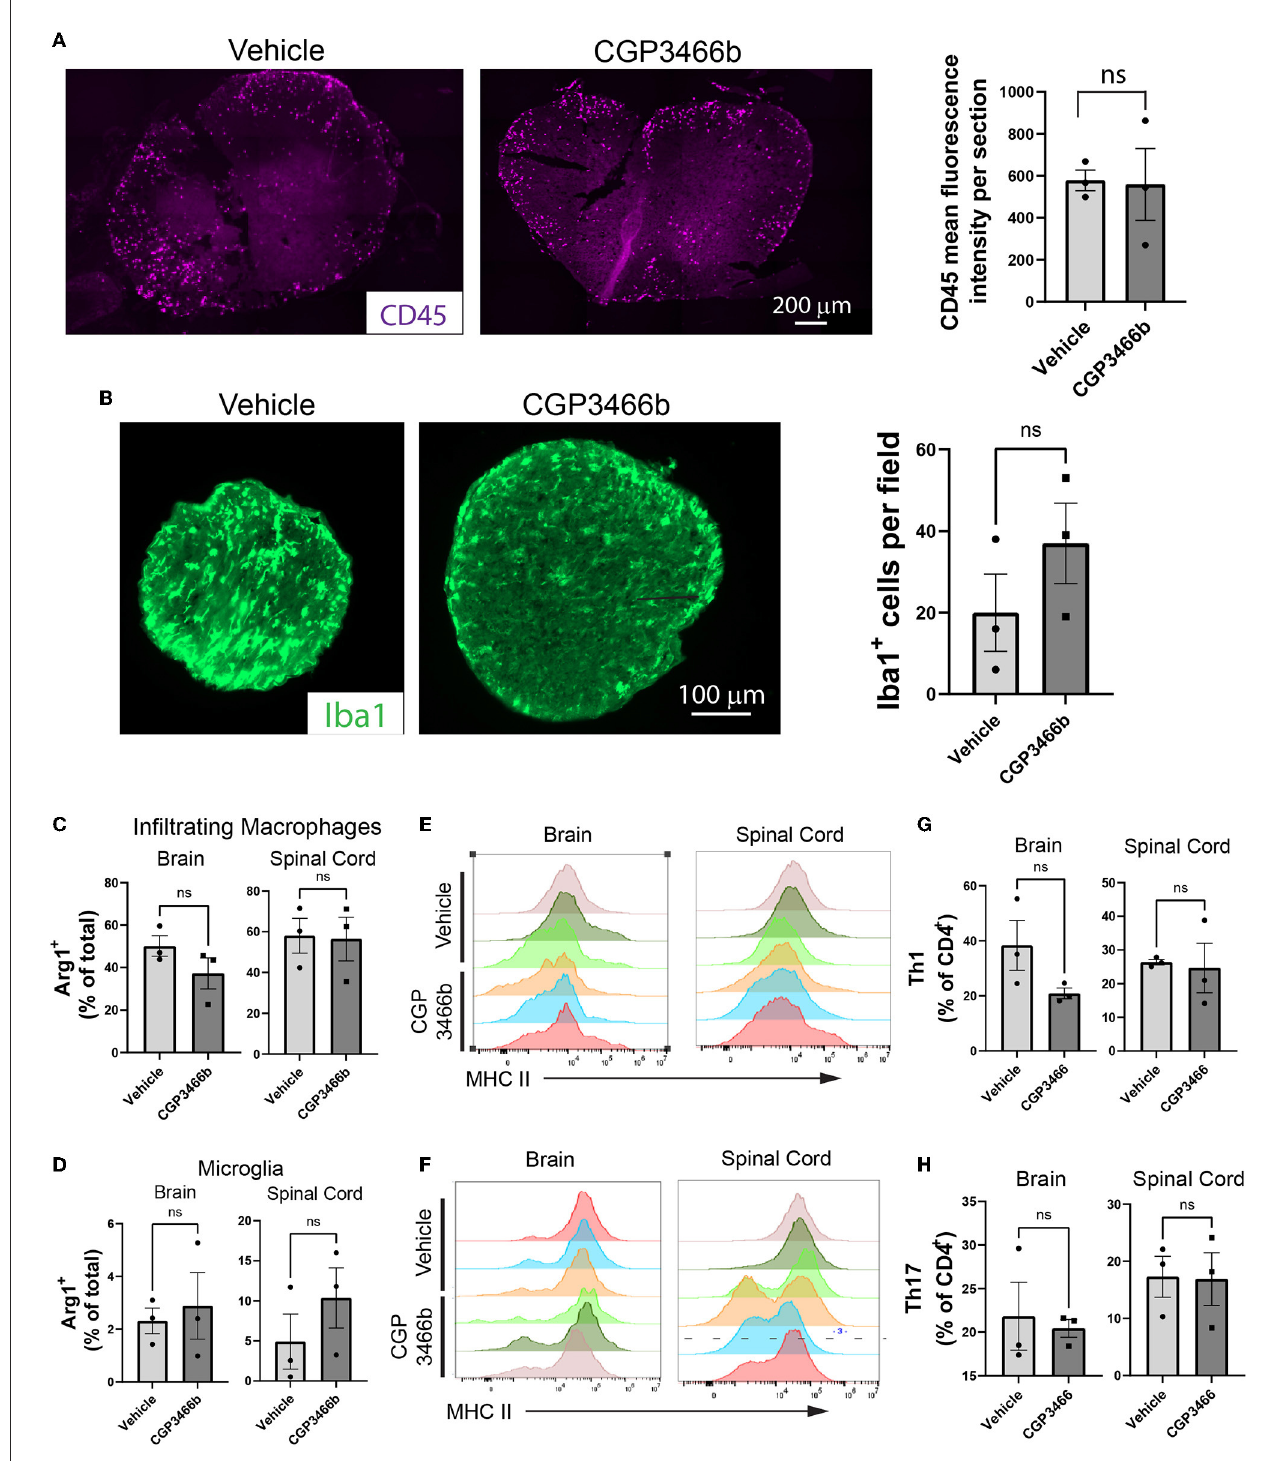
FIGURE4 CGP3466b does not impact CNS immune infiltration in MOG 35 − 55 EAE. (A) CD45 + infiltrates in lumbar spinal cord at post-immunization day 18. Mice were treated with vehicle or 4 mg/kg CGP3466b daily starting on post-immunization day 0. A representative image is shown ( left ), along with quantification performed from n = 3 mice per group ( right ). (B) Iba1 + infiltrates in optic nerve at post-immunization day 28. Mice (the same cohort depicted in Figure 2D) were treated with vehicle or 4 mg/kg CGP3466b daily starting on post-immunization day 0. A representative image is shown ( left ), along with quantification performed from n = 3 mice per group ( right ). (C) Infiltrating macrophages and (D) resident microglia in the brain and spinal cord were examined via flow cytometry on post-immunization day 18 for expression of arginase-1 as a percentage of total macrophages or microglia, respectively. Data represent mean ± SEM of 3 mice per group. (E) Infiltrating macrophages and (F) resident microglia were examined via flow cytometry on post-immunization day 18 for expression of MHC II, shown as mean fluorescence intensity. Data shown from 3 mice per group. (G) Th1 cells and (H) Th17 cells were quantified via flow cytometry on post-immunization day 18 in the brain and spinal cord as a percentage of total CD4 + cells. Data represent mean ± SEM of 3 mice per group. All statistical analyses performed with student’s t